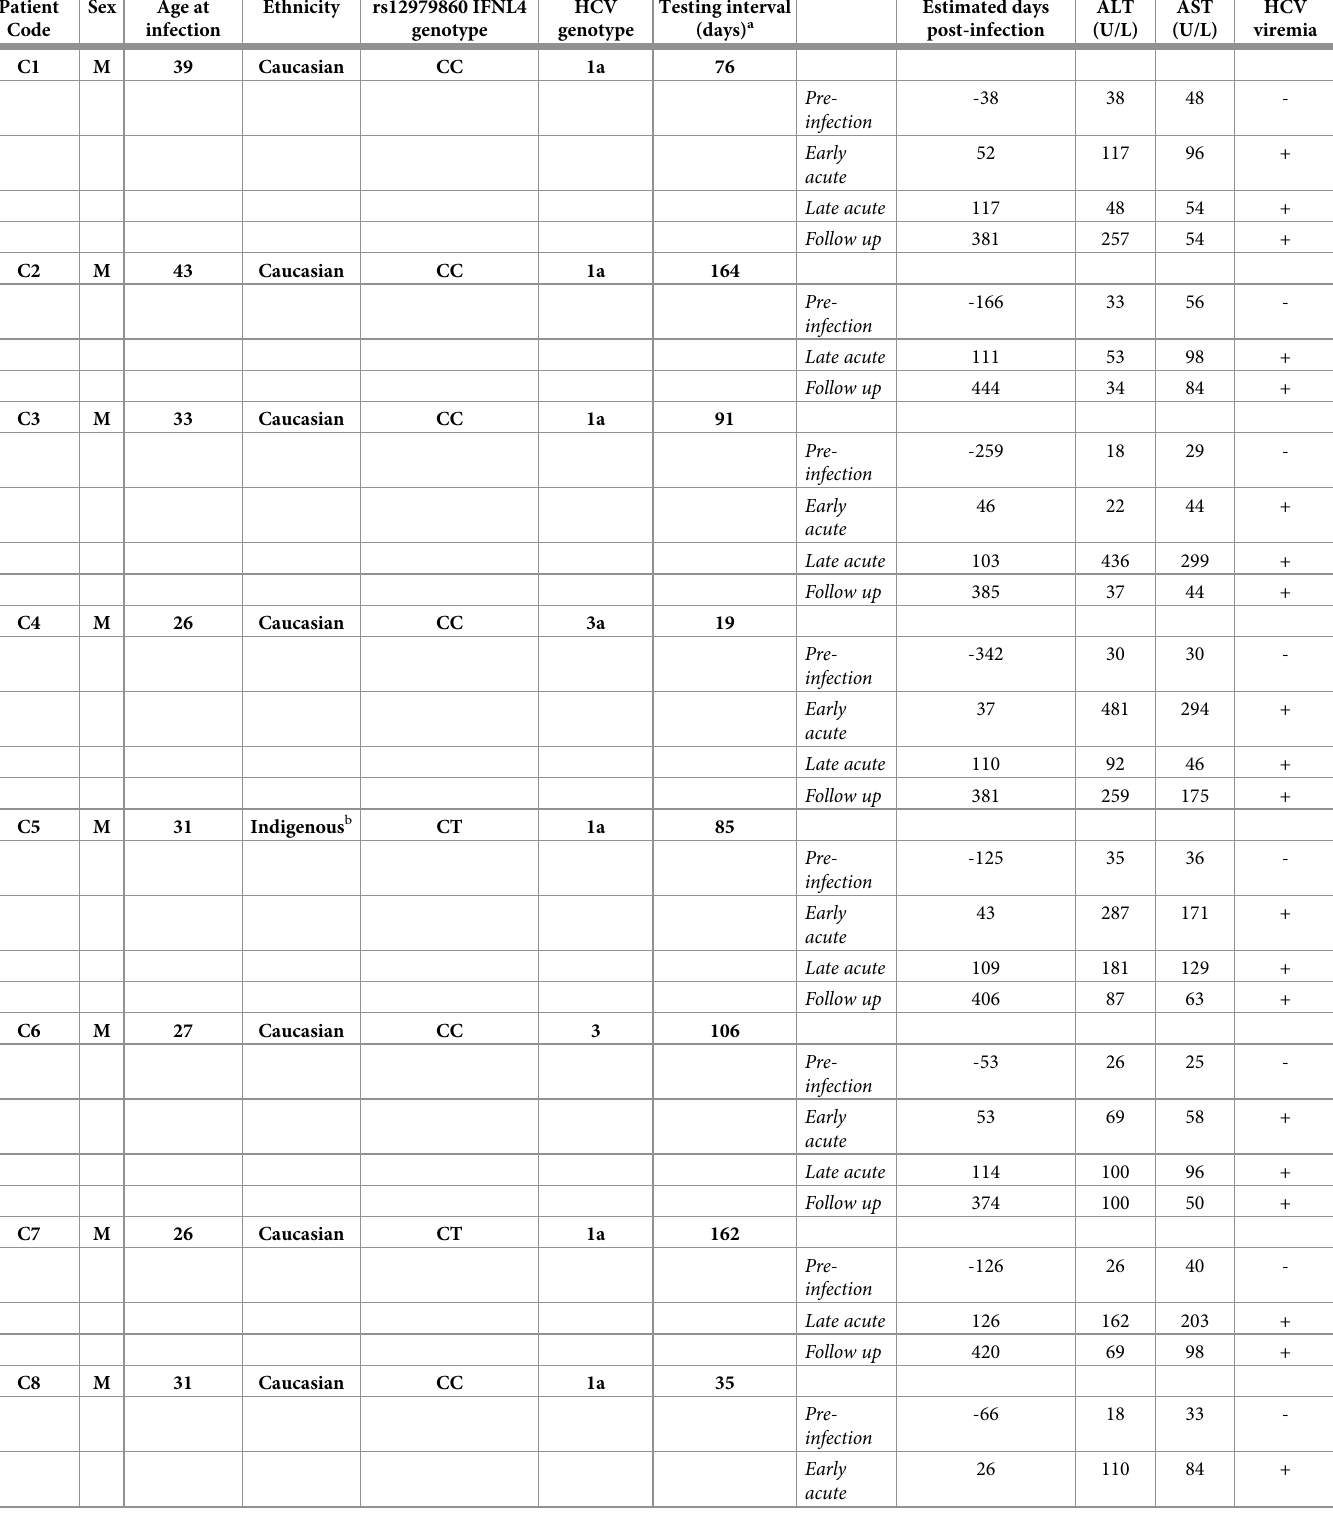
Table 2. Patient demographics and clinical information for samples analyzed by RNA-Seq: Chronic group. Patient